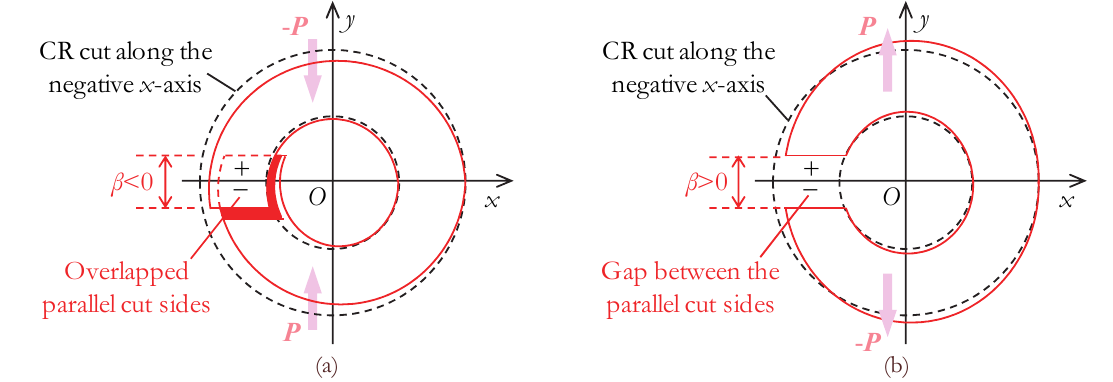
Figure 2: The nature of the β -dislocation and the resulting transverse forces for (a) negative and (b) positive values.